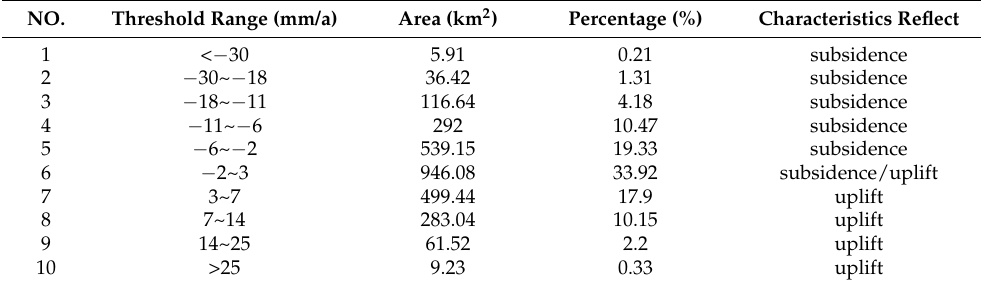
Table 4. Statistics of InSAR surface deformation anomaly information in Yongping County